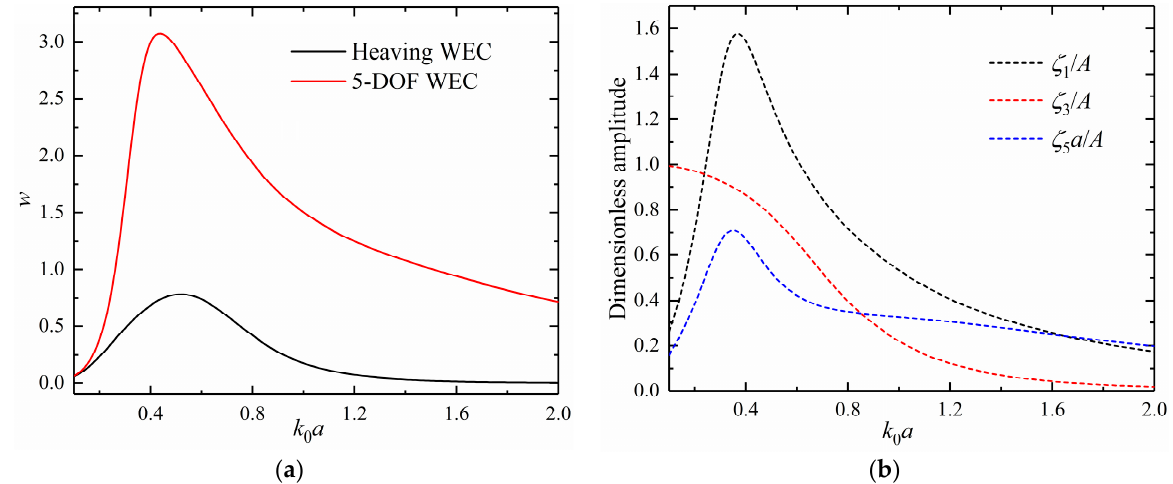
Figure 5. Results of an isolated WEC: ( a ) capture width; ( b ) dimensionless motion amplitudes of